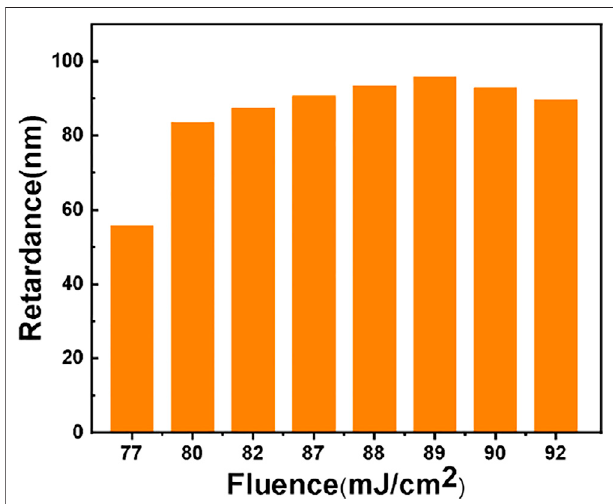
FIGURE 10 | The retardance as a function of laser fl uence from a 1,030 nm laser. The scanning speed is 0.01